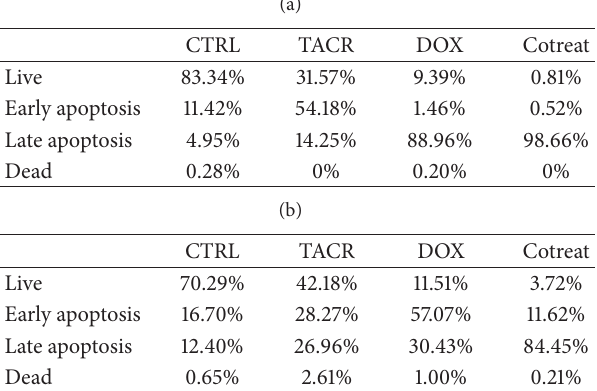
Table 2: Percentage of live, early apoptotic, late apoptotic, and dead cells by the Muse Annexin V and Dead Cell assay in Huh7 (a) and HepG2 (b) cell